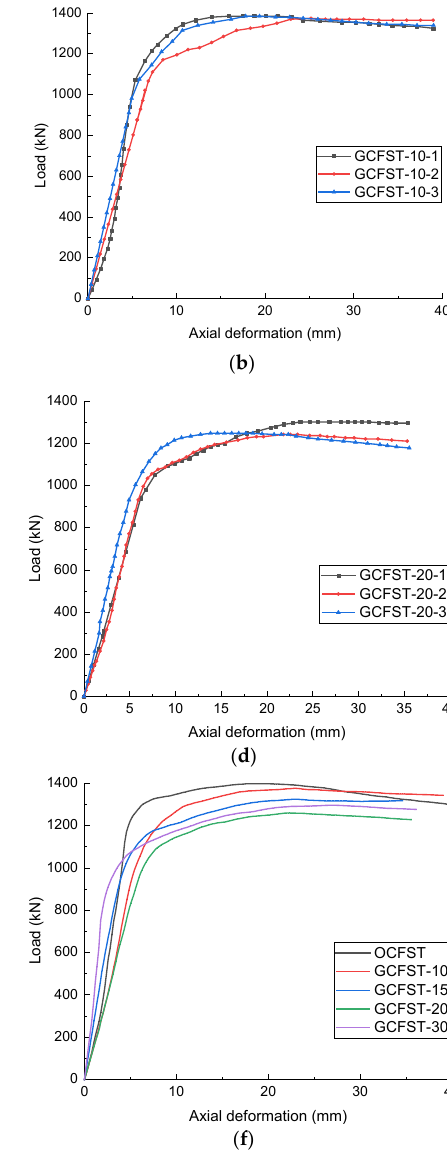
Figure 10. Load–deformation response for all specimens: ( a ) OCFST specimens; ( b ) GCFST-10 specimens; ( c ) GCFST-15 specimens; ( d ) GCFST-20 specimens; ( e ) GCFST-30 specimens; ( f ) comparison of average load–deformation response for different specimens. Table 3. Summary of the test results.